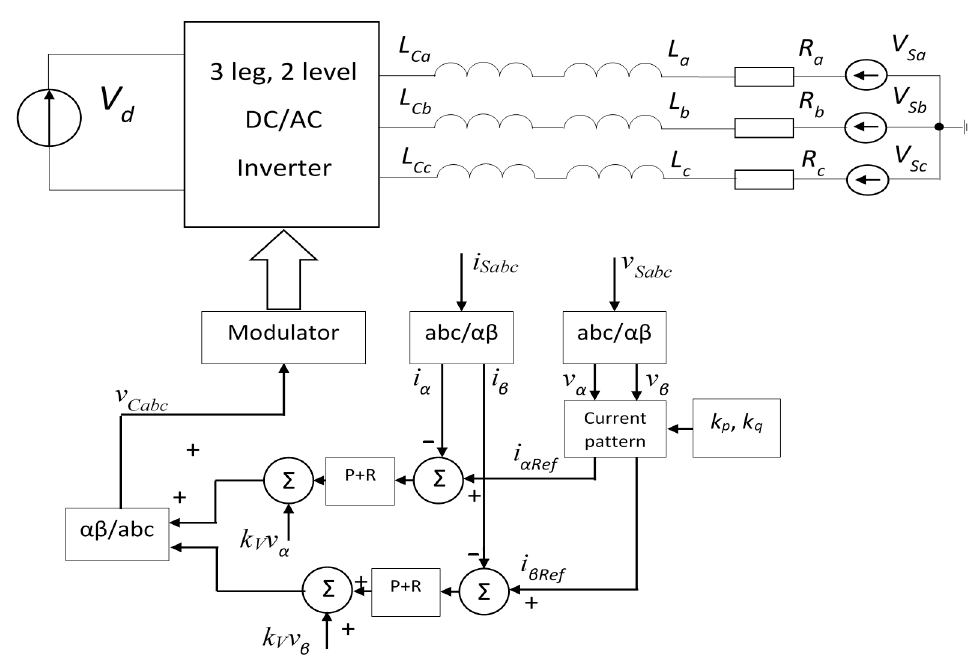
Figure 11. Block diagram of the implemented system.